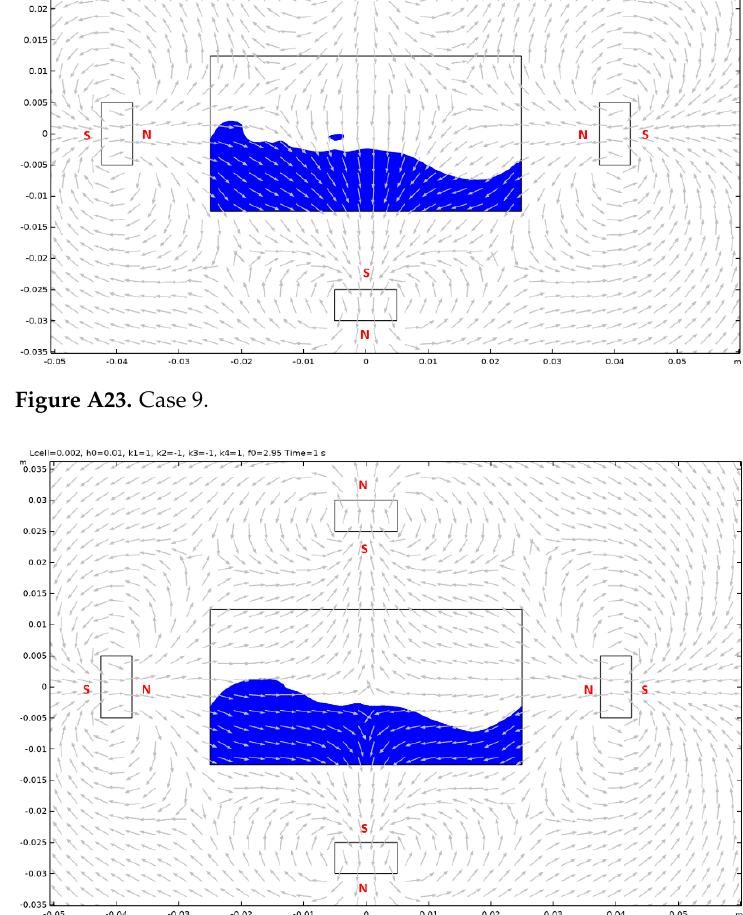
Figure A24. Case Figure A24. Case 10. Figure A24. Case 10.